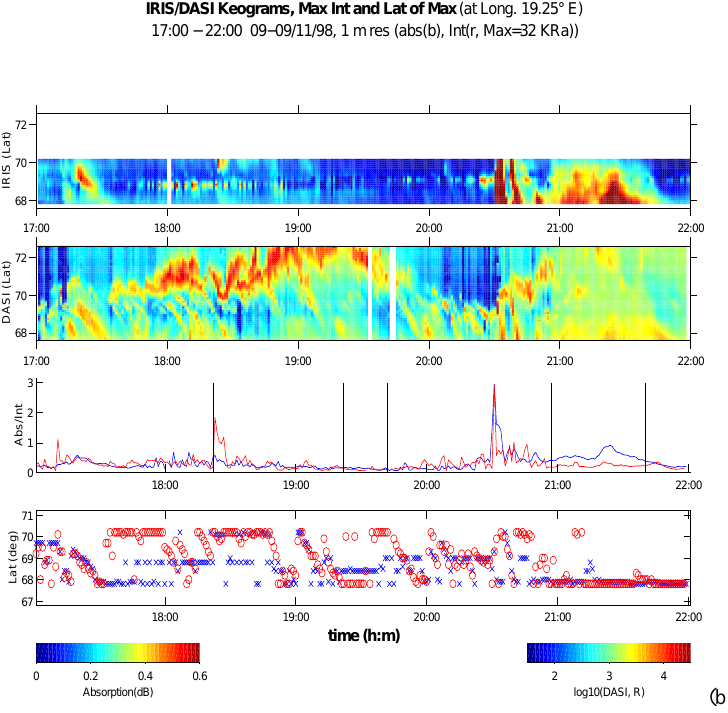
Fig. 1. Composite plots for observation periods (a) 17:00–01:00UT, 13–14 February 1996, and (b) 17:00–22:01UT, 09 November 1998. The time resolution in all cases is 1min. In all cases, we display together the keograms at 19.25 ◦ lon. (Tromsø) from IRIS absorption (top panel) and from the DASI green-line emission (second from top) for the respective fields of view of the instruments. The intensities and latitude of maximum absorption (blue) and maximum luminosity (red, normalised to the absorption) in the common field of view are shown in the third panel from the top, and in the bottom panel, respectively. Colour bars at the foot of the figure give the scales of absorption in dB and light emission in